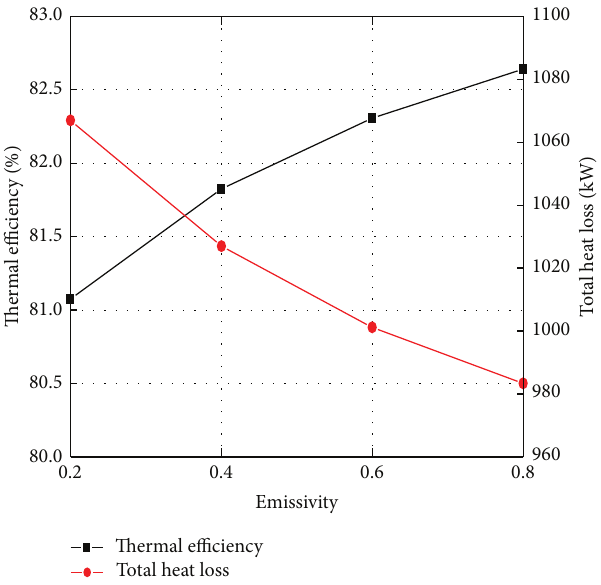
Figure 7: Thermal efficiency and total heat loss of the receiver.